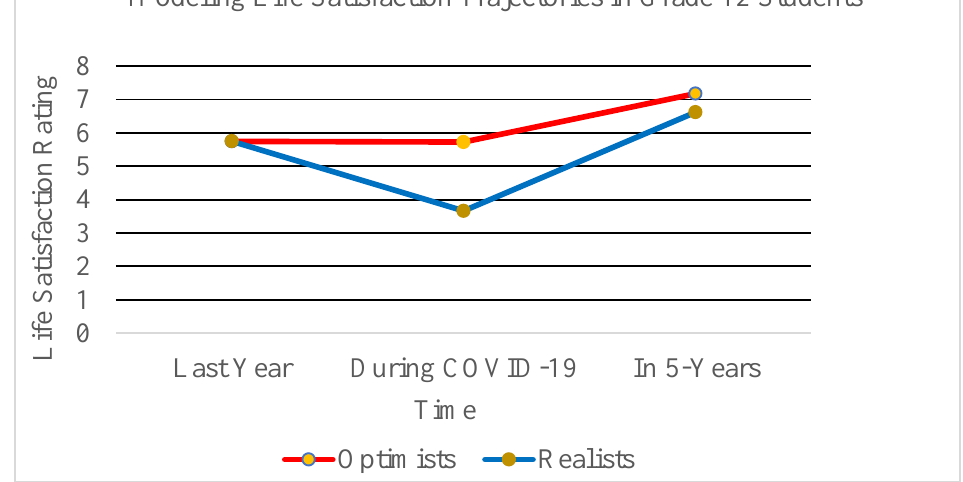
Figure 1. Latent classes of life satisfaction over time.